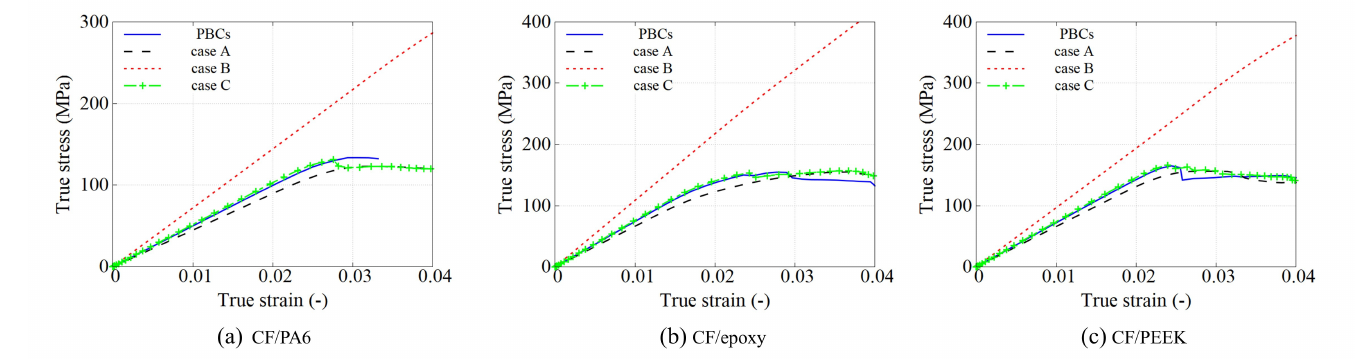
Figure 16. Comparison of true stress–strain curves of 4 different types of BCs using three popular UD composites at the strain rate of 100 s − 1